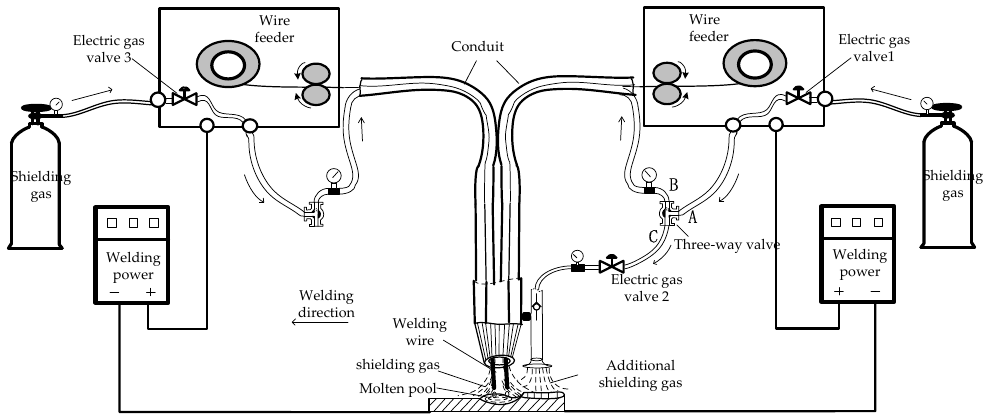
Figure 1. Schematic diagram of the twin wire pulsed MIG welding under additional shielding gas.